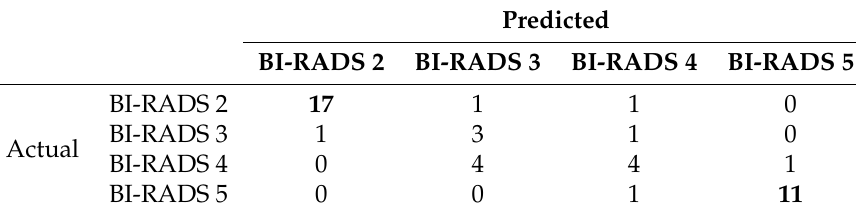
Table 7. RF confusion matrix.